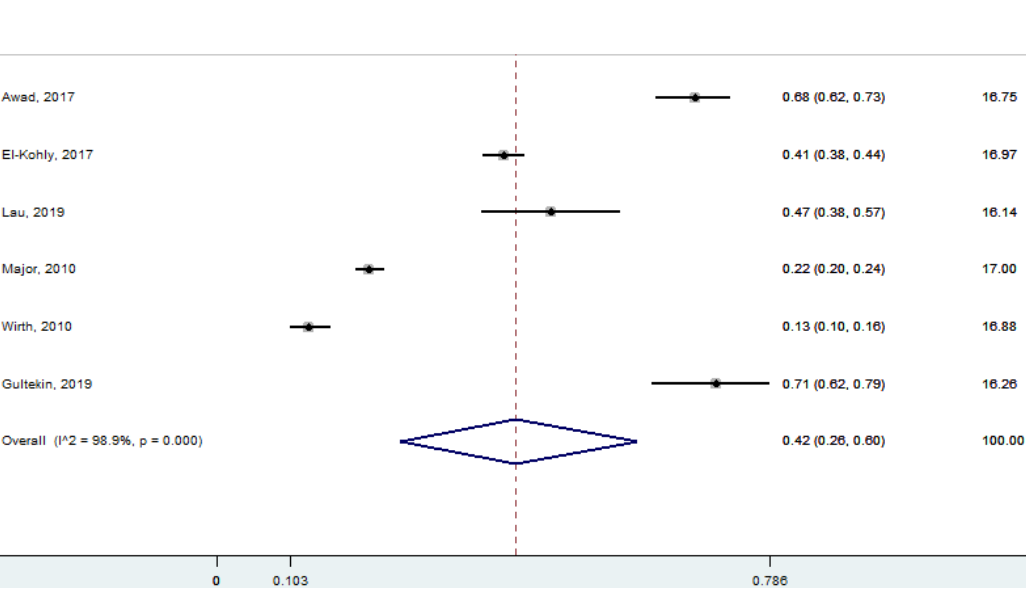
Figure 5. Decision/choice of patients in self-care and self-medication (six